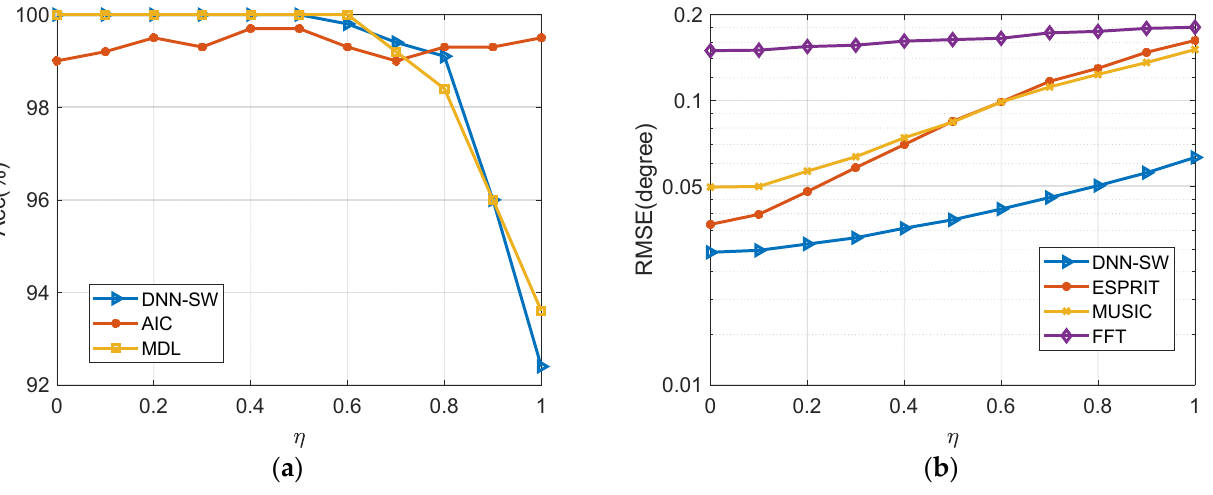
Figure 6. The DOA estimation performance with array imperfection. η is an imperfect factor The gain-phase error and position perturbation are 3 η dB, 30 η ◦ , and 0.15 λη , respectively. ( a ) Acc ( b )